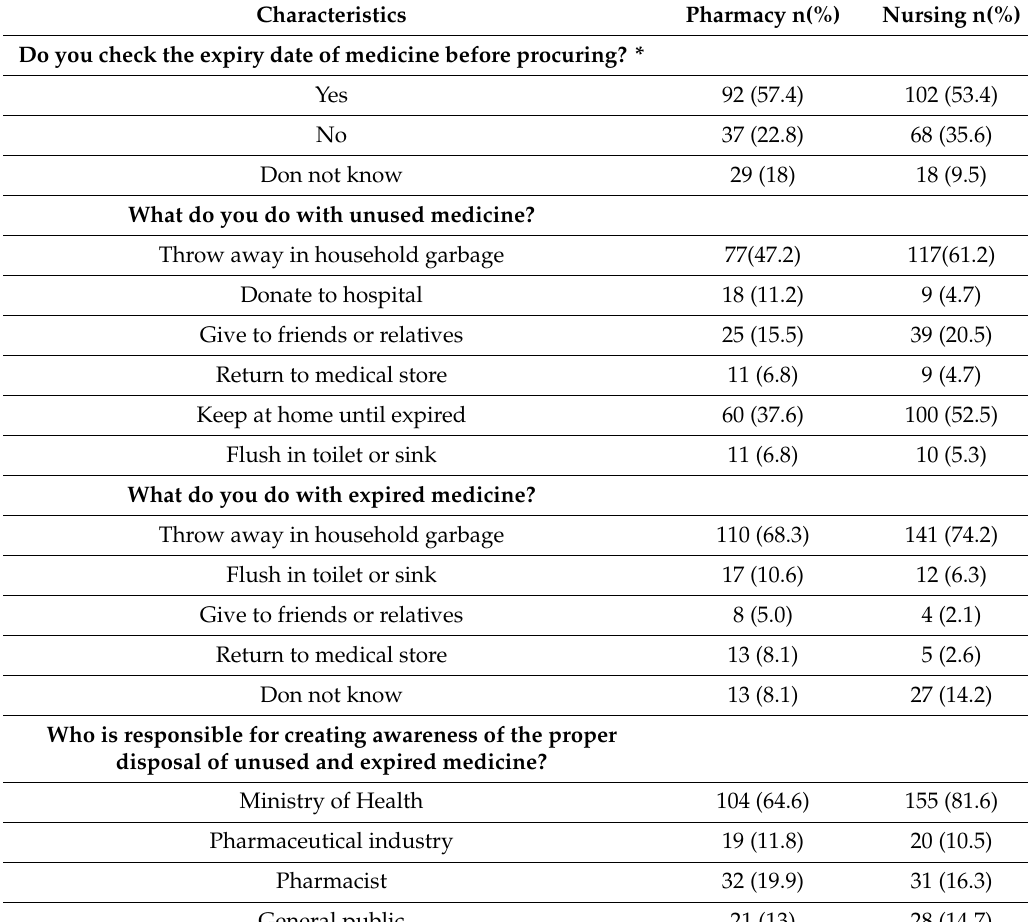
Table 2. Knowledge and practice regarding unused and expired medicine among Saudi pharmacy and nursing students. Characteristics Pharmacy n(%) Nursing